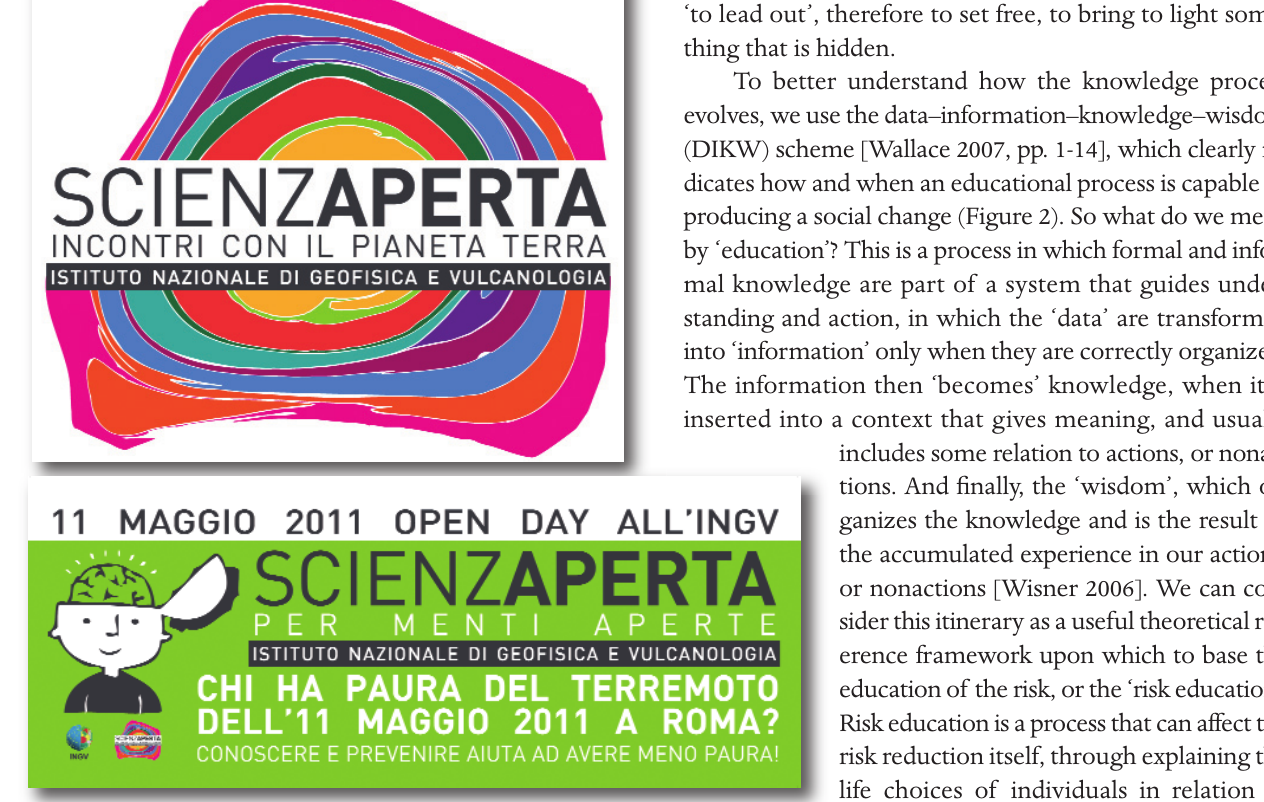
Figure 1 (above and previous page). Posters of the initiatives for the popularization of science from